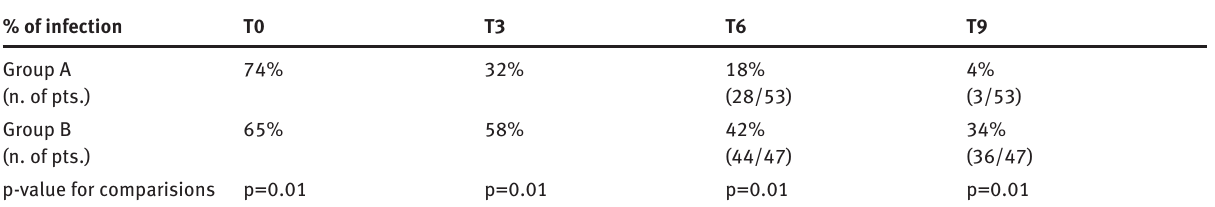
Table 4: Percentage of infection in ulcers of Group A (CGF) and Group B (controll) at first observation time (T0) and after 3 (T3), 6 (T6) and 9 (T9)